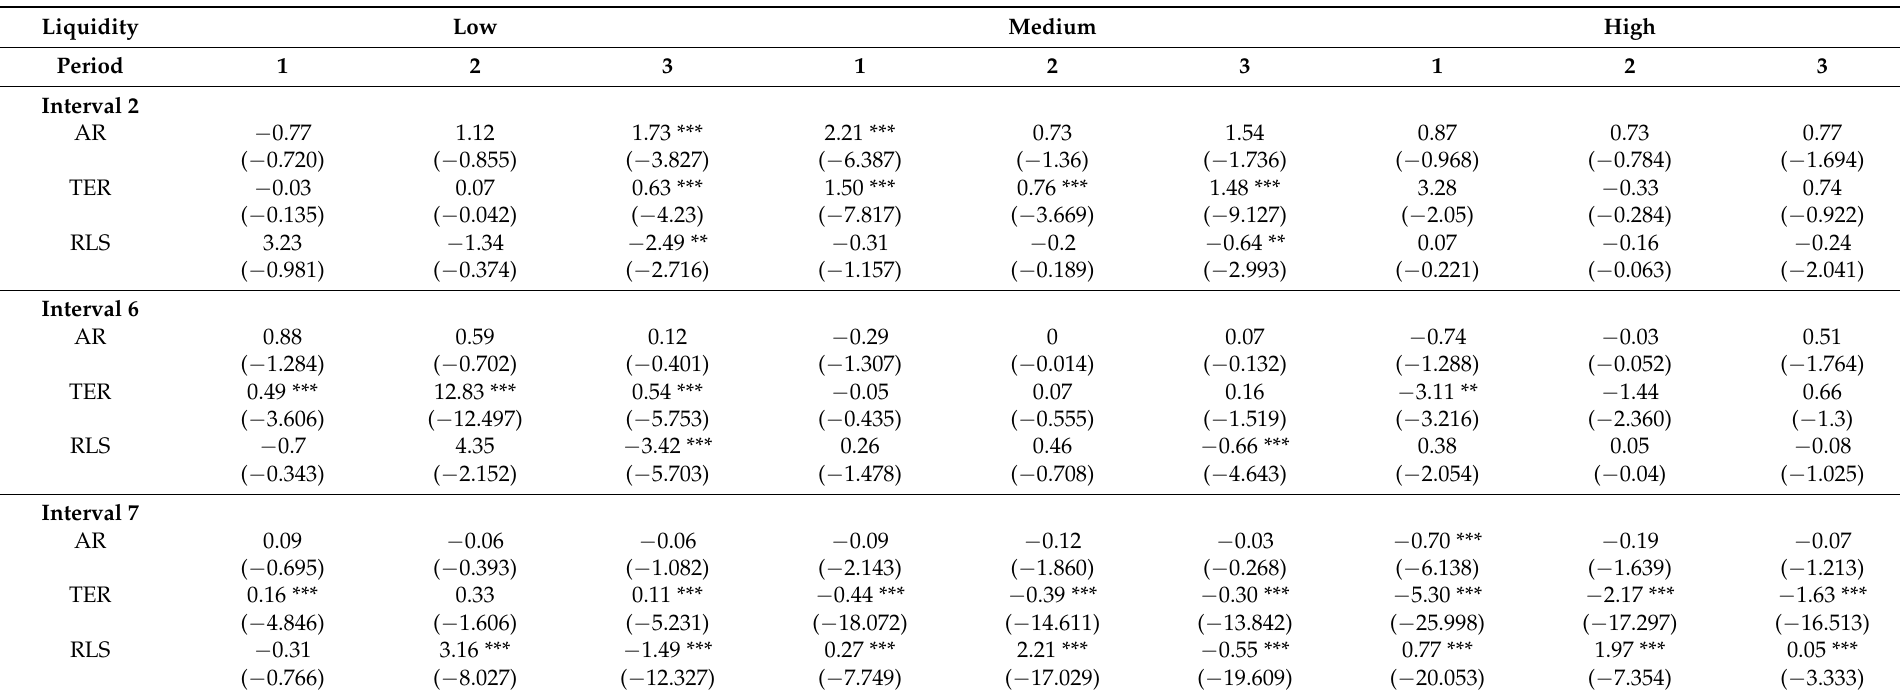
Table 2. Abnormal returns (%) and liquidity measures (%) by study period control variable: liquidity prior to announcement. Liquidity Low Medium